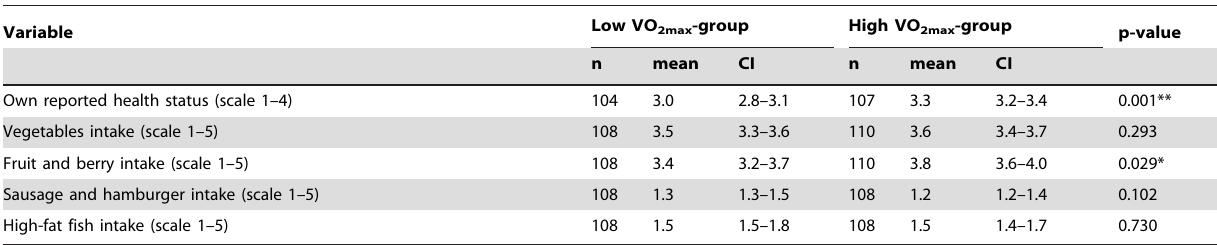
Table 2. Data from questionnaires.